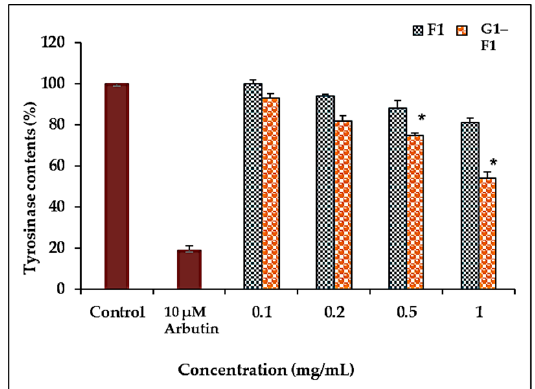
Figure 4. Inhibitory effects of ginsenoside F1 and α -glycosylated ginsenoside F1 on Mushroon tyrosinase activity. Tyrosinase activity was measured using 3.3 mM L ‐ DOPA as a substrate. Results